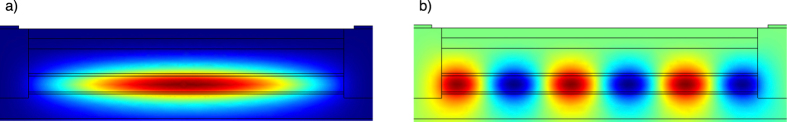
Simulated TM0 (a) and TM5 (b) electric field intensity.